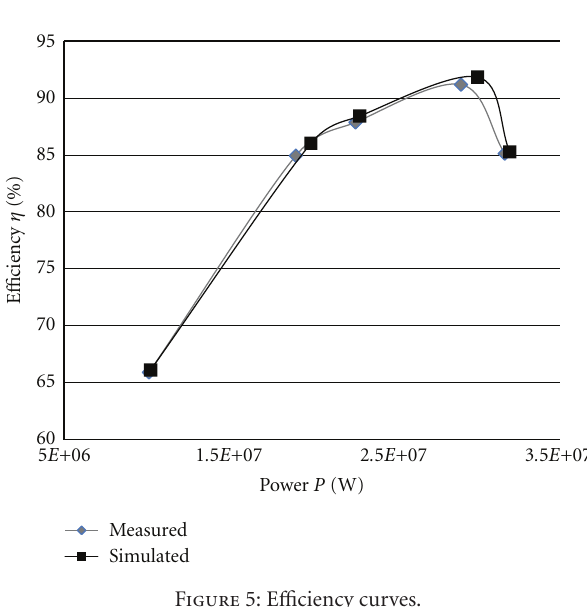
Figure 5: E ffi ciency